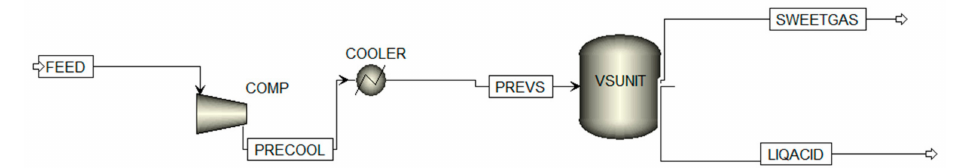
Figure 5. Process flow diagram of the SV separation